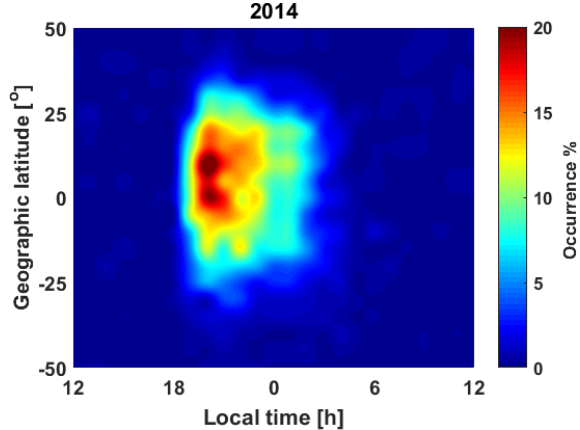
Figure 4. Latitudinal and local time dependence of equatorial plasma bubble occurrence in 01:00LT by 5 ◦ latitudinal grid during 2014.